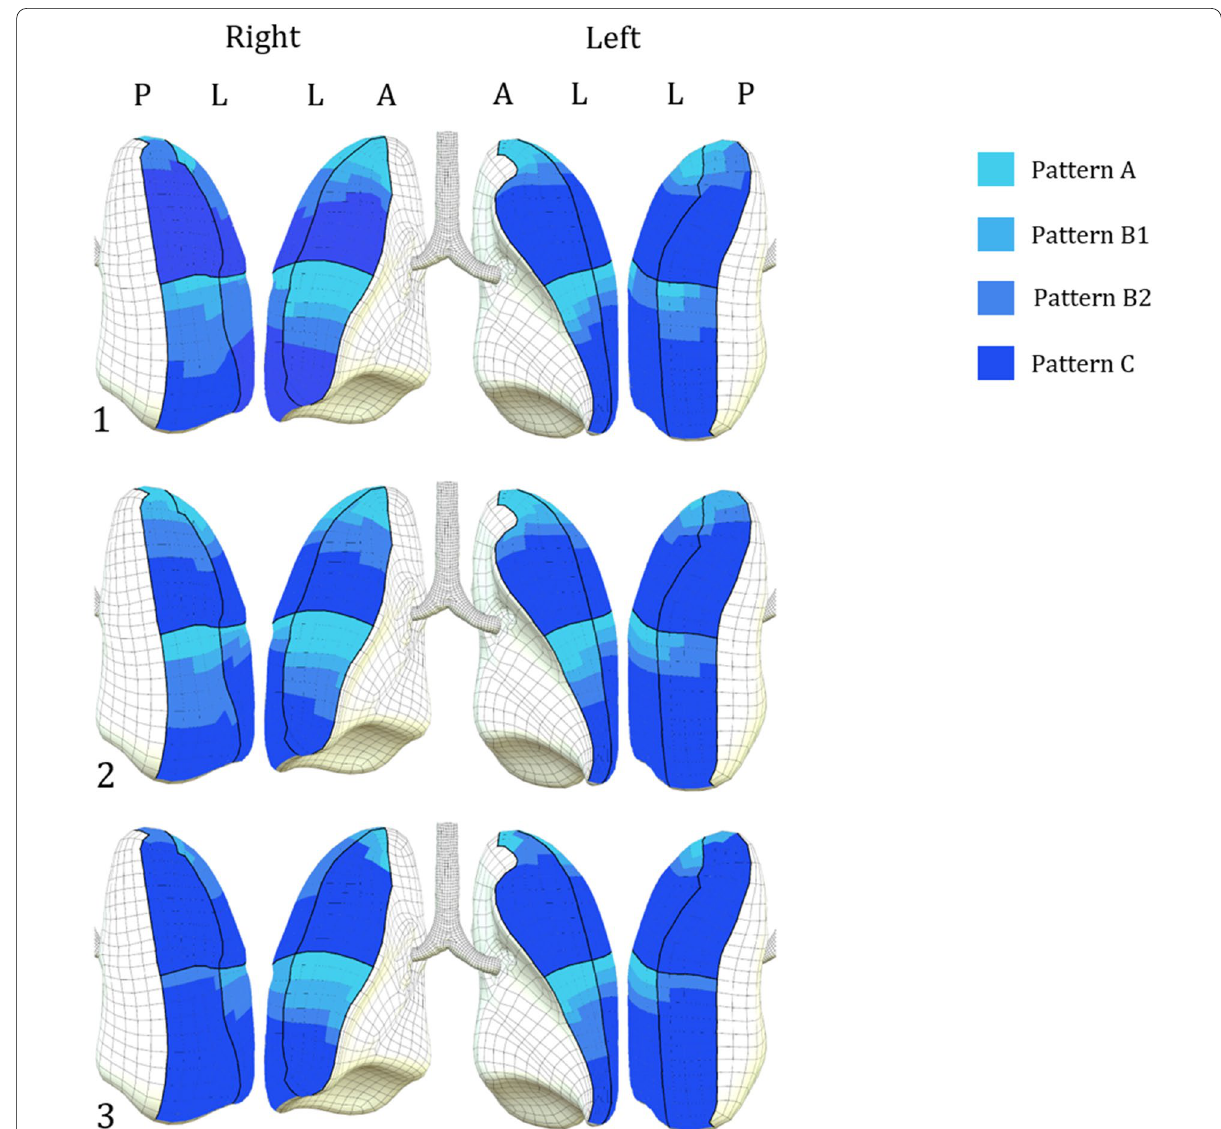
Fig. 2 LUS patterns frequency distribution on the twelve investigated areas on the day of ICU admission (1) and at discharge considering survived (2) and non-survived patients (3): the number of squares of each colour is proportional to the percentage of presentation of each pattern in the considered region. Examined regions were posterior ( p ), lateral ( l ), split between the front and back views, and anterior ( a ) for both hemithoraces, each one divided into superior and